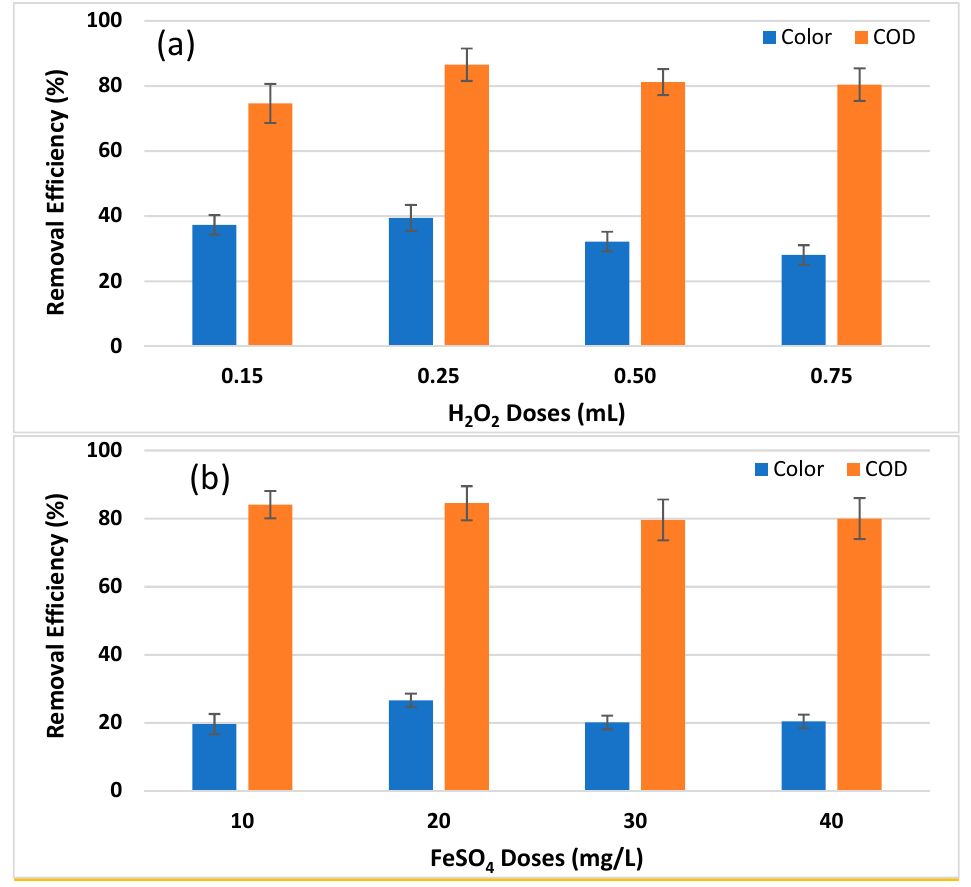
Figure 7. ( a ) Optimization of H 2 O 2 dose of treated pulp and paper wastewater for Fenton oxidation at di ff erent doses (0.15, 0.25, 0.50 and 0.75 mL) for biologically treated wastewater. ( b ) Optimization of FeSO 4 dose of treated pulp and paper wastewater for Fenton oxidation at di ff erent doses (10, 20, 30 and 40 mg/L) for biologically treated wastewater. Means values are presented with standard deviation.